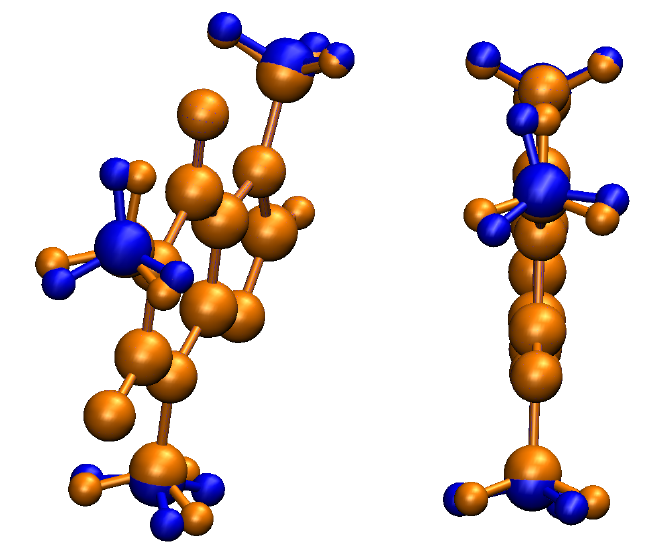
Figure 7. Hyperconjugative effects on the molecular geometry of caffeine. Selectively removing all non-Lewis orbitals involved in the bidirectional –CH 3 (cid:28) aromatic charge transfer leads to an enlargement of the C–N bonds in the H 3 C–N groups and to out of plane C–H bonds (blue